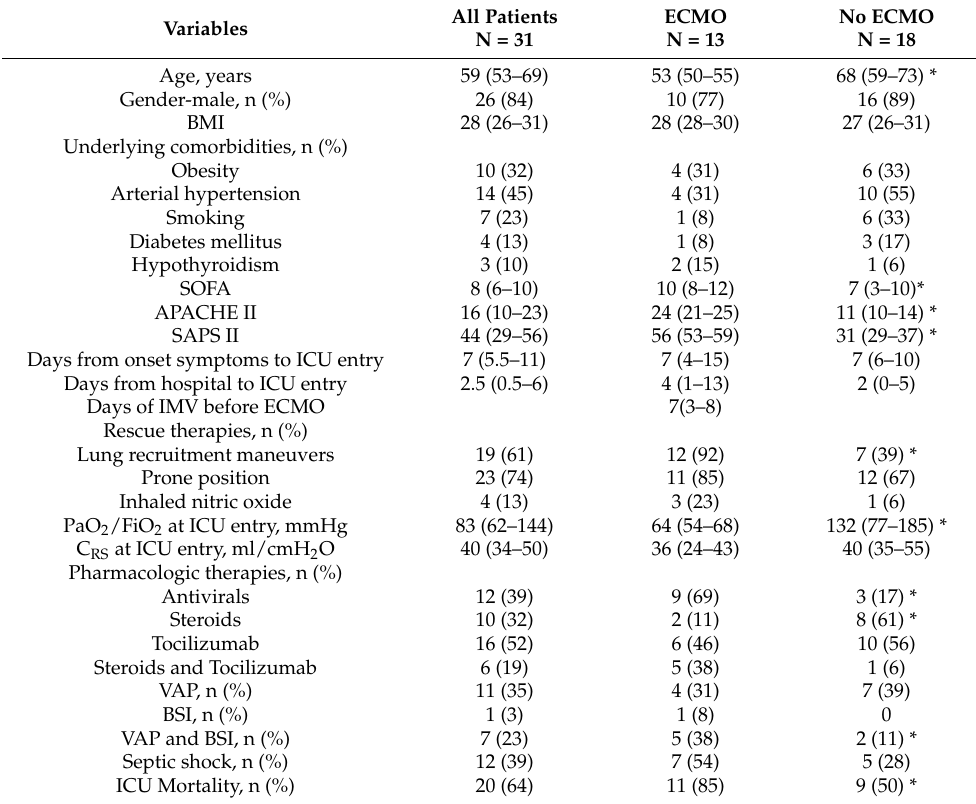
Table 1. Baseline characteristics of the Sars-CoV-2 patients treated or not with VV-ECMO.